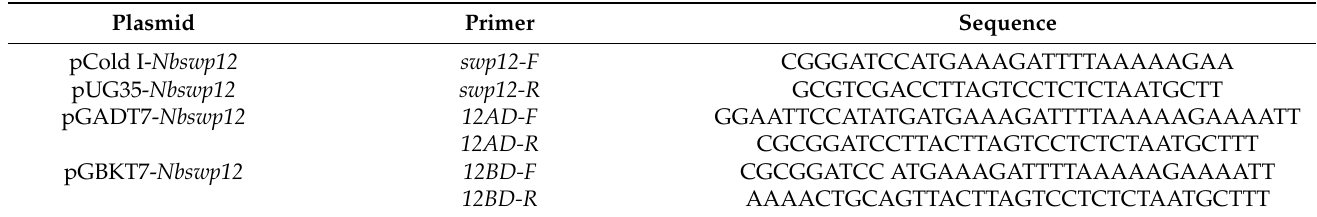
Table 1. Primers used in this